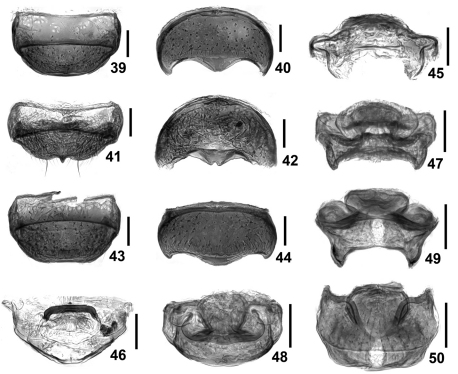
Details of Intestinariusspp., female. 39, 41, 43 tergite VIII 40, 42, 44 sternite VIII 45, 47, 49 female genitalia, posterior view 46, 48, 50 same, dorsal view 39, 40, 45, 46 Intestinarius guangdongensis41, 42, 47, 48 Intestinarius kuzmini 43, 44, 49, 50 Intestinarius longiceps.